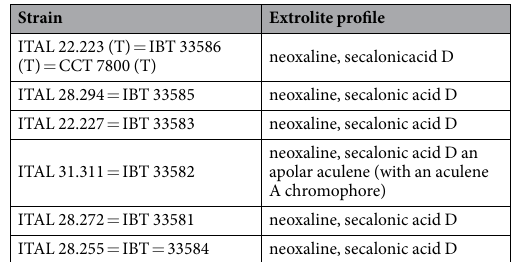
Table 2. Extrolite profiles of Aspergillus labruscus strains * . * Strain ITAL 28.275, ITAL 22.225 and ITAL 28.256 also produced secalonic acid D and